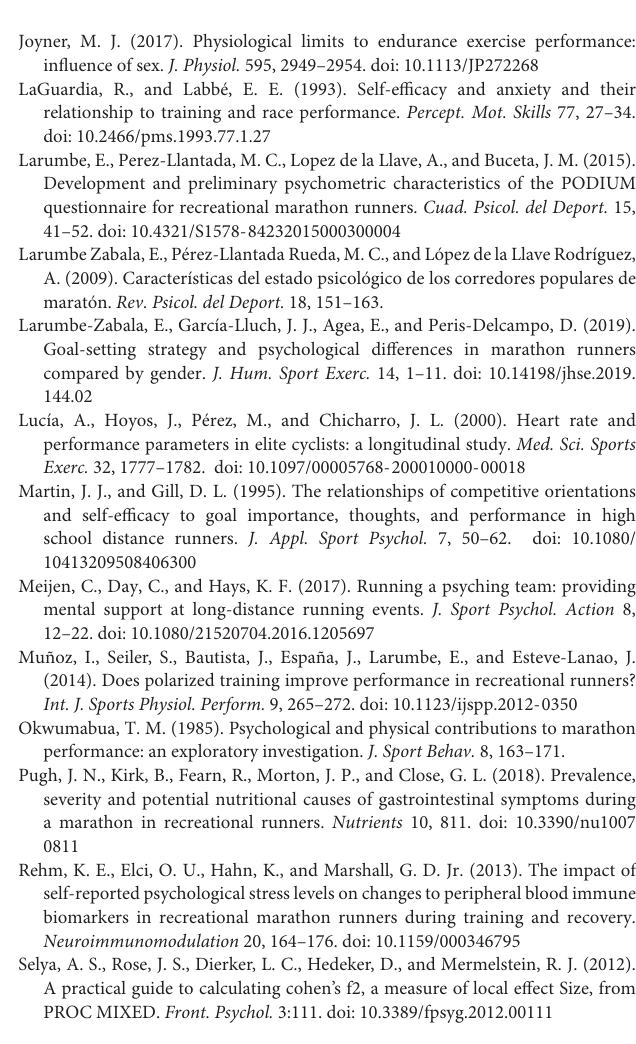
FIGURE S1 | Spaghetti plots of Podium questionnaire variables during the course of the study. Each line represents one study participant. FIGURE S2 | Spaghetti plots of physiological performance parameters during the course of the study. Each line represents one study